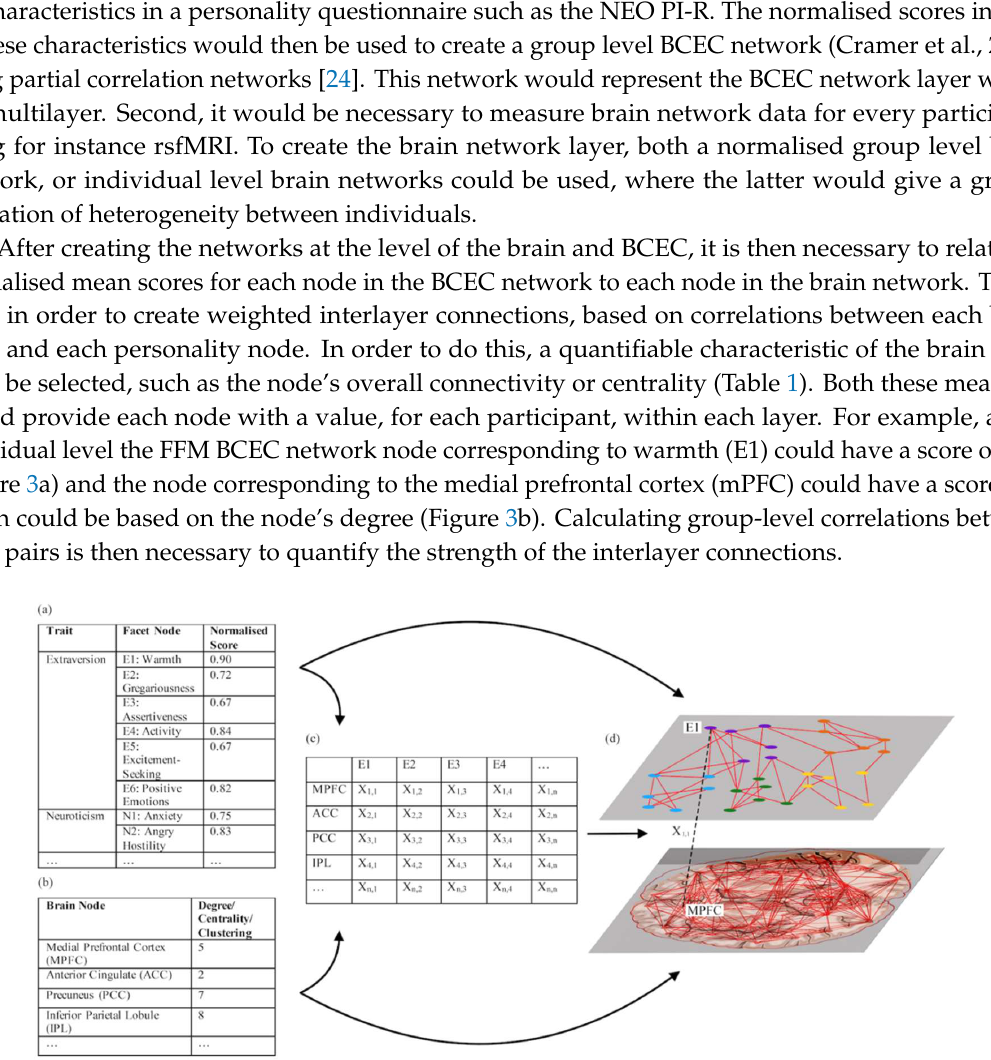
Figure 3. Methodology for multilayer approach without interlayer identities. ( a ) Normalised personality scores in every facet of a personality the FFM (Friendliness = Extraversion One (E1)) are collected from a sample of individuals and used to make a BCEC network by means of the Partial Correlation network methodology. This data is used to create the BCEC network layer in the multilayer network ( d ). ( b ) Brain network nodes are defined and network characteristics, such as degree, clustering and centrality, are quantified for the original sample of individuals. This is used to create a brain network layer in the multilayer network ( d ). ( c ) A matrix is created which quantifies the correlations between each node in the personality data and each node in the brain data, this matrix score is then used to define the weight of the intralayer connections (X n,n ).